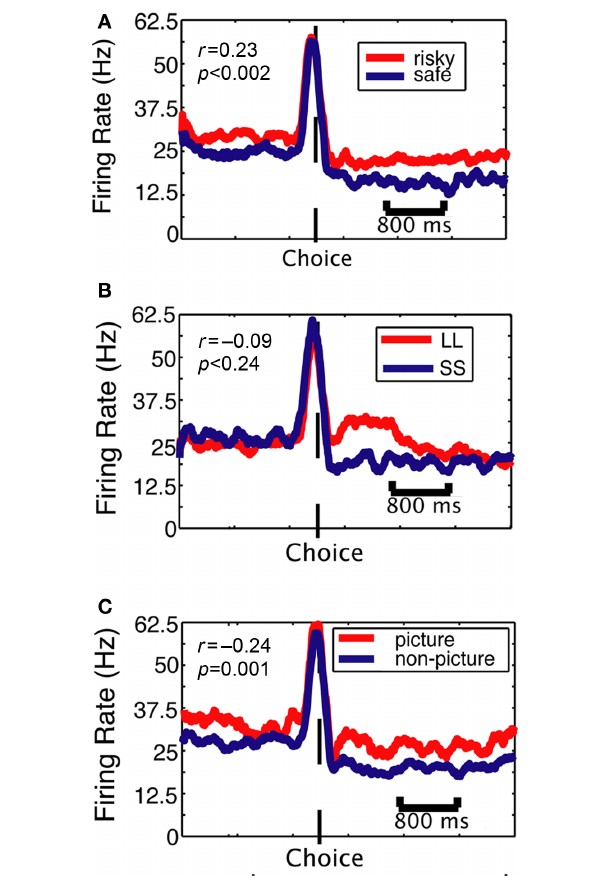
Figure 3 | Firing rates of a single Cgp neuron are modulated by choice but do not signal value independent of decision context. Plots are aligned to end of choice saccade (dotted line). (A) Risk context. PSTH shows average response of population of neurons when monkey chose the risky option (red) or the safe option (blue). (B) Delay context. PSTH separated by whether the monkey chose the LL option (red) or the SS option (blue). (C) Social valuation context. PSTH separated by whether the monkey chose the picture option (red) or the non-picture option (blue). Pre-choice modulations likely reflect block structure (see main text). Statistics are for correlation between subjective value and firing rate, within